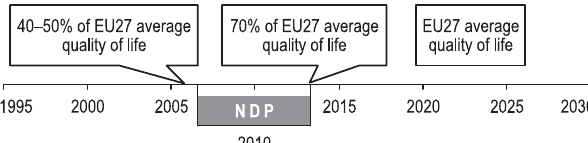
Fig. 11. QoL: planned average annual increase for 2007–2013